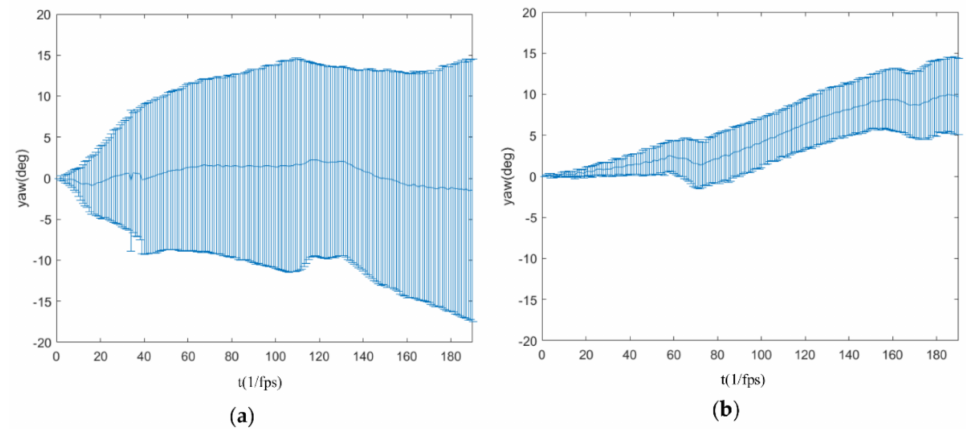
Figure 14. The yaw angle of the ball versus time in each leg motion loop. The solid line indicates the average value of each time, and the error bar indicates the standard deviation of each time: ( a ) 40 ◦ –70 ◦ rolling range; and ( b ) 50 ◦ –80 ◦ rolling